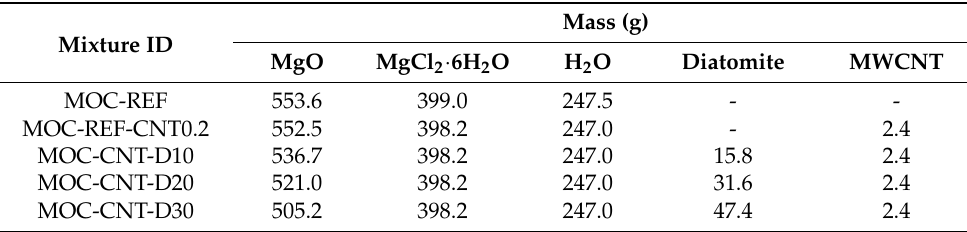
Table 1. Mixture properties of prepared samples.